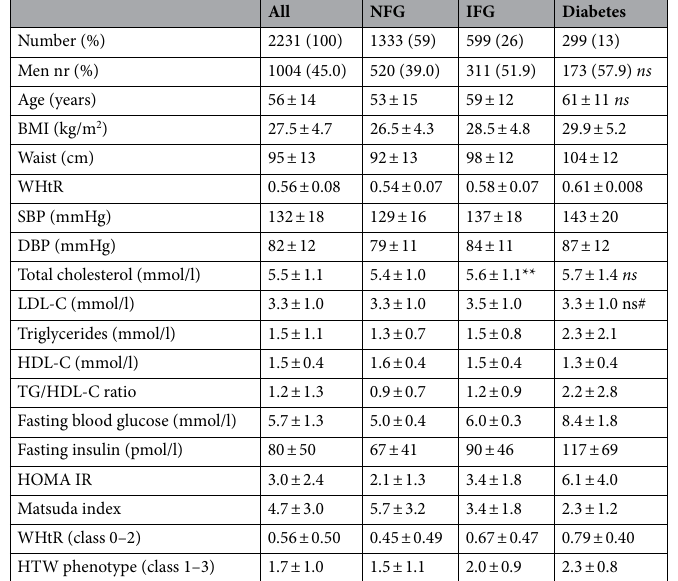
Table 1. Characteristics of all participants: differences between the subgroups are p < 0.001 unless indicated otherwise. Data are given as mean ± standard deviation. In comparison to NFG ns = no significance, * p < .05 and ** p < 0.01. In comparison to IFG ns = no significance , # p < 0.05 and ## p < 0.01. NFG normal fasting glucose, IFG impaired fasting glucose, SBP systolic blood pressure, DBP diastolic blood